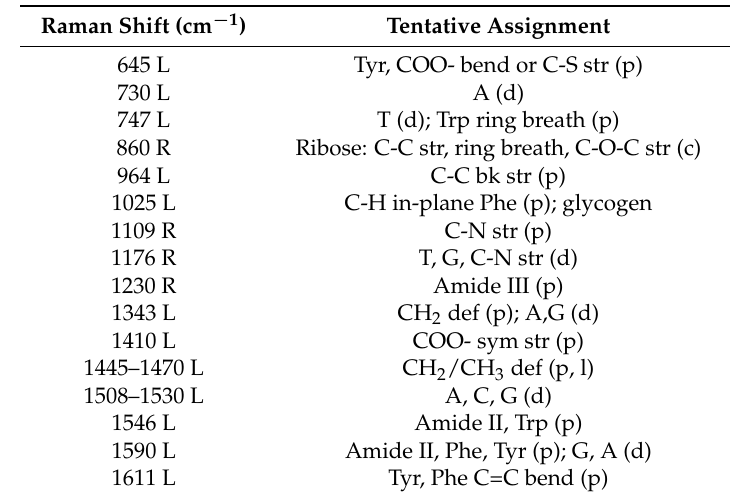
Figure 6. BP-AuNSs-based SERS analysis of the different encephalic regions. ( a ) The mean SERS spectra extracted from four different encephalic regions (CTX, cerebral cortex; HYP, hypothalamus; TH, thalamus; Hi, hippocampus) in left or right hemisphere. ( b ) The mean SERS spectra of brain tissues in left and right hemispheres, as well as the SERS difference spectrum of left versus right hemisphere. ( c ) SERS difference spectra of left versus right hemisphere in four encephalic regions. Table 1. The assignments of the Raman bands in SERS difference spectrum of left versus right